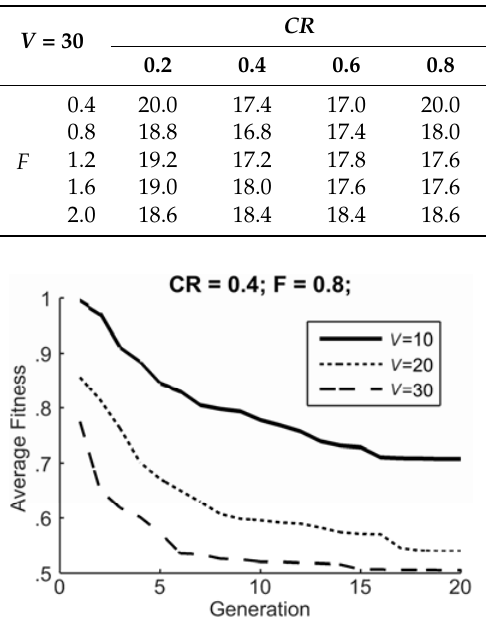
Table A3. The average number of generations to converge to fitness 0.5, over 5 trials, for V = 30, and for different combinations of CR and F .